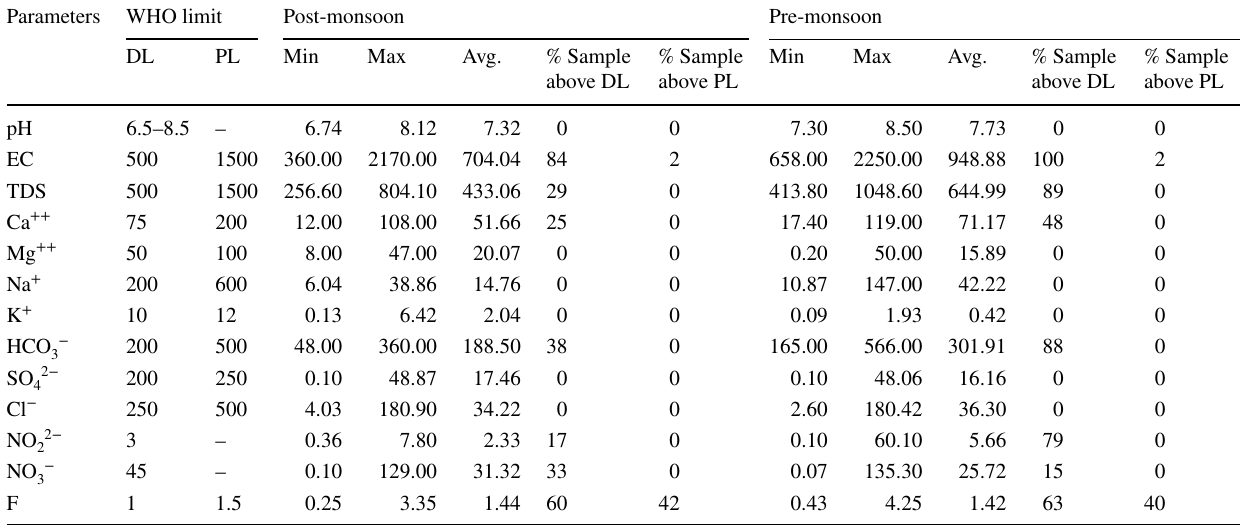
Table 1 Descriptive statistics and comparison of physicochemical analysis with WHO (2011) limit of the study area during post- and pre-mon- soon seasons